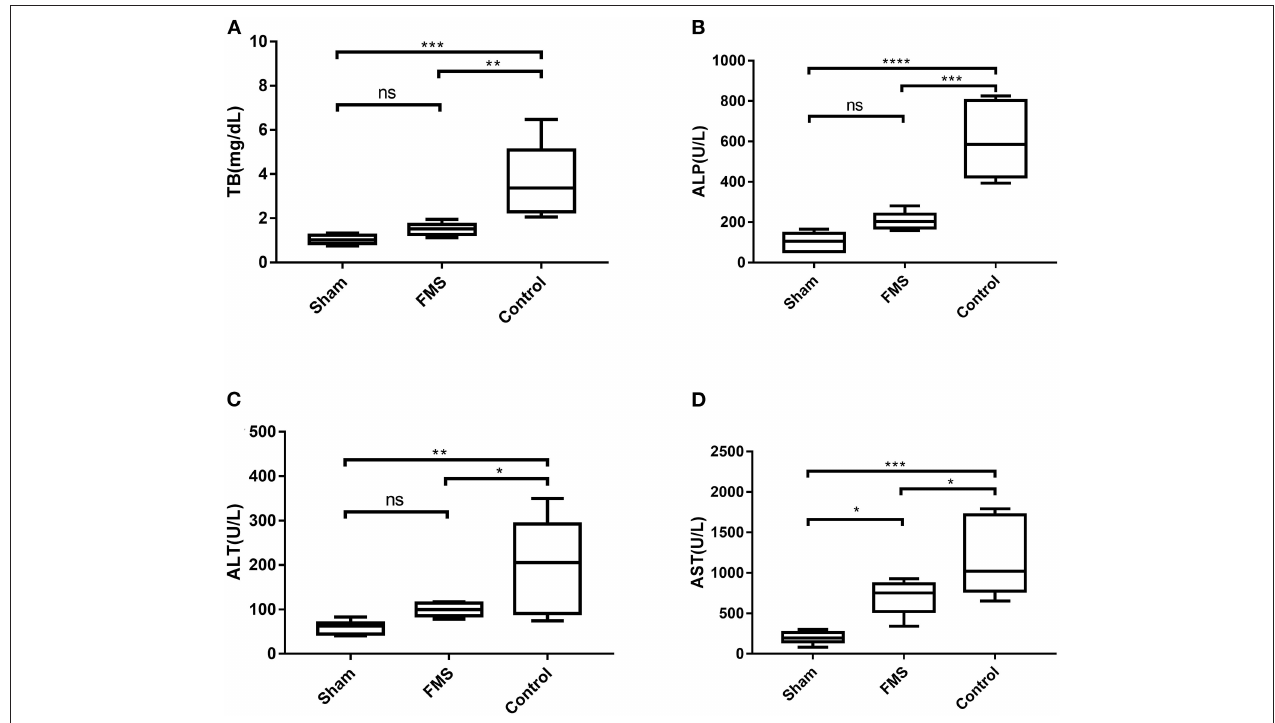
FIGURE 5 | The FMS reconstruction attenuates bile duct anastomosis-induced liver damage. (A) Total bilirubin (TB) of the three groups. (B) alkaline phosphatase (ALP) of the three groups. (C) ALP of the three groups. (D) AST of the three groups. * P < 0.05,** P < 0.01,*** P < 0.001, and **** P <